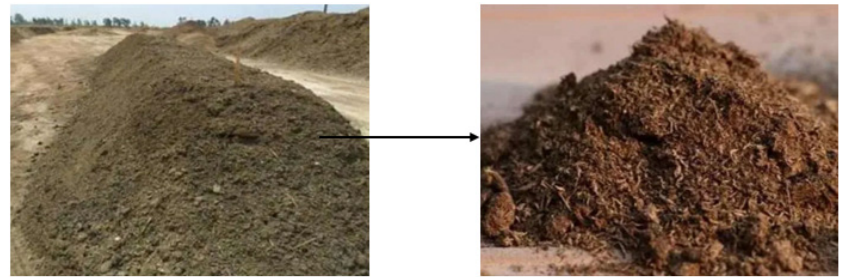
Figure 2. Manure extraction in Rio Paranaíba—MG, Brazil.